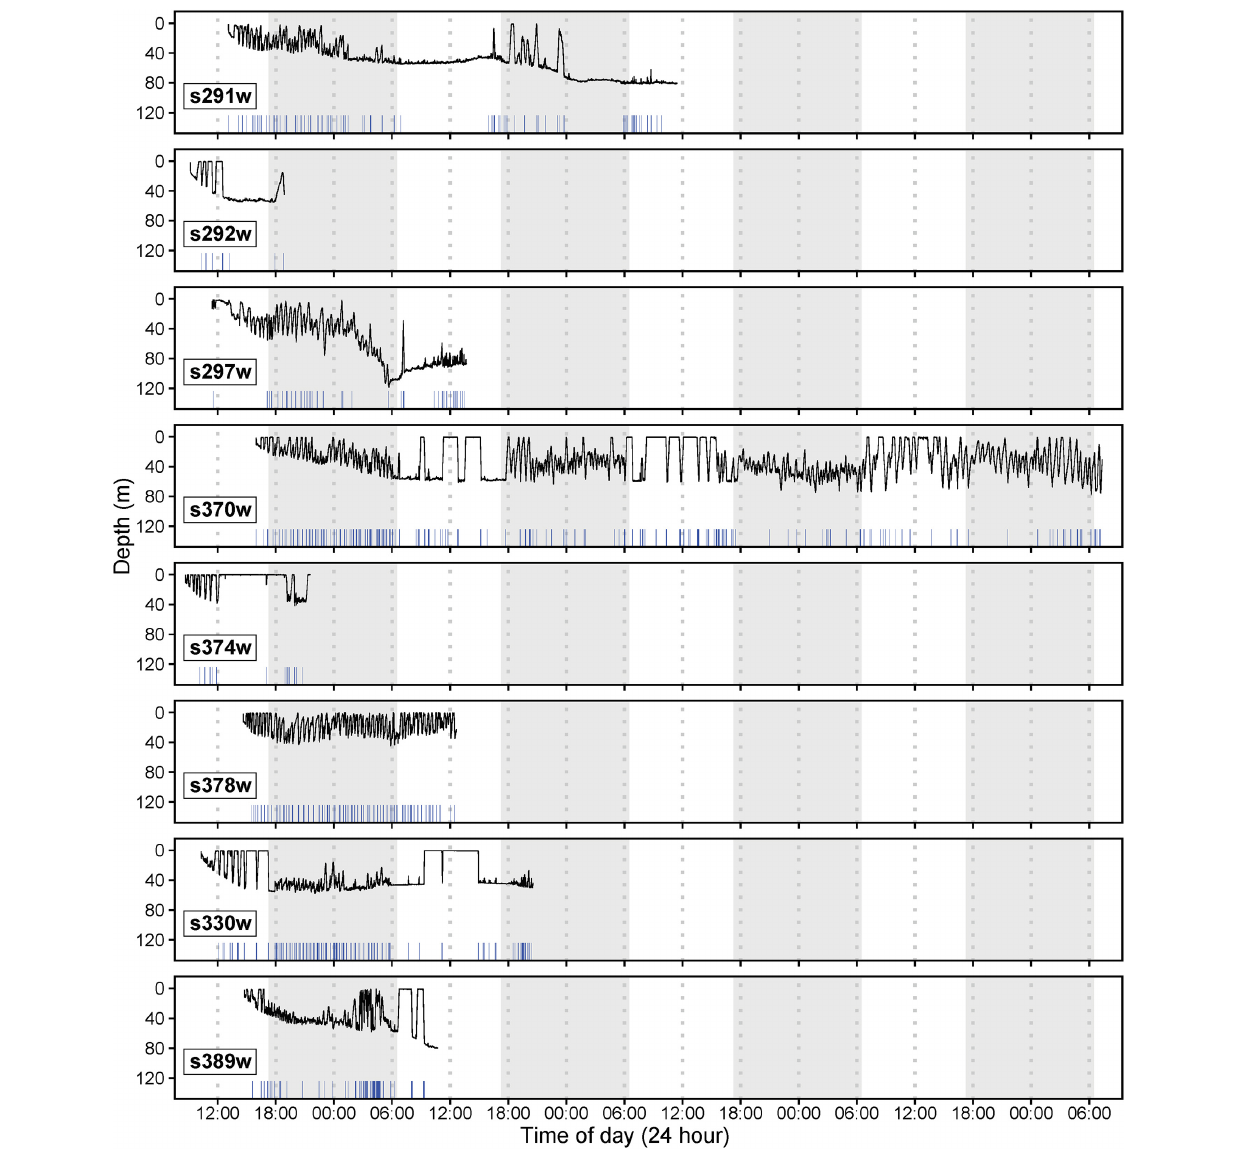
FIGURE 4 | Diving profiles for eight deployments of CATS cams on white sharks released from SMART drumlines (shark ID numbers indicated in bottom left of panels). White and gray shading indicates day and night (sunset to sunrise), respectively. X -axis rug plots indicate instances of gliding behavior (no tailbeat) determined through tailbeat